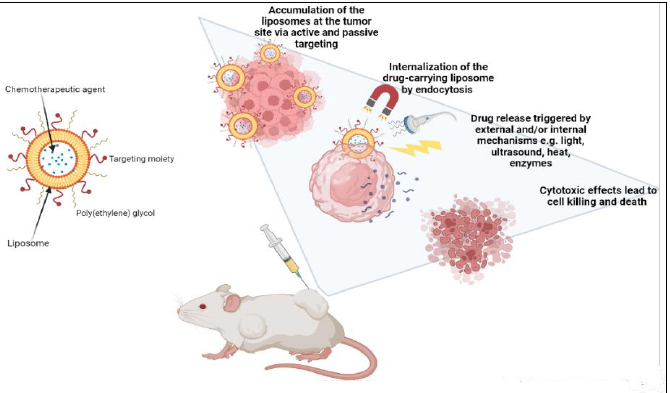
Figure 2. Demonstration of cancer treatment using a liposome-based drug delivery